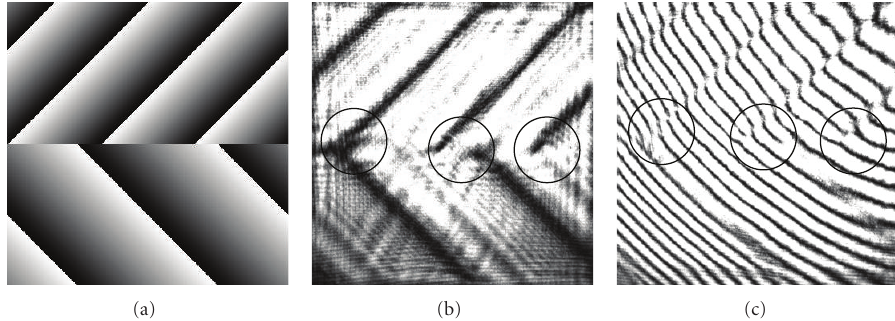
Figure 6: (a) Phase distribution for oppositely inclined linear phase ramps with di ff erent tilts. (b) Experimentally observed intensity distribution of propagated field when phase mask corresponding to (a) is displayed onto the SLM. (c) Formation of fork fringes when the propagated field interfers with a plane wave coming from the other arm of the Mach-Zehnder